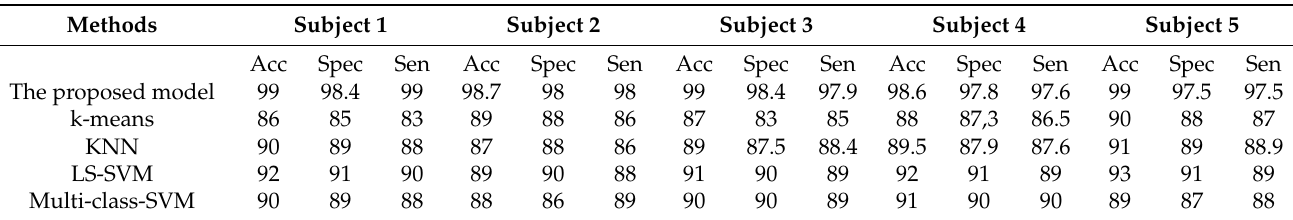
Table 9. Comparison of the proposed model with other